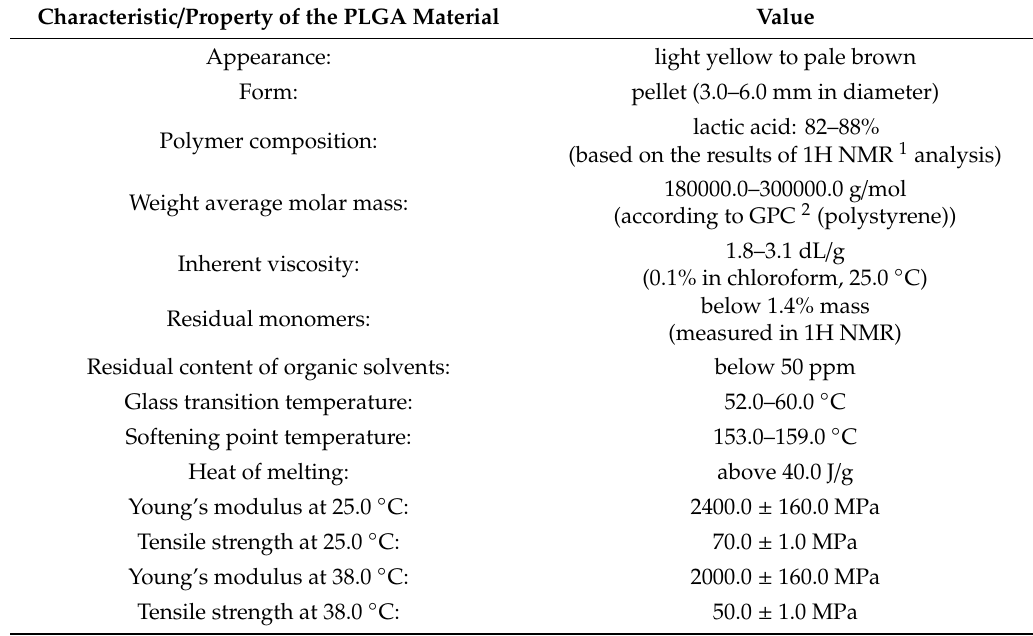
Table 1. Basic physical-chemical properties of the PLGA polymer provided by CPCM [25]. Characteristic / Property of the PLGA Material